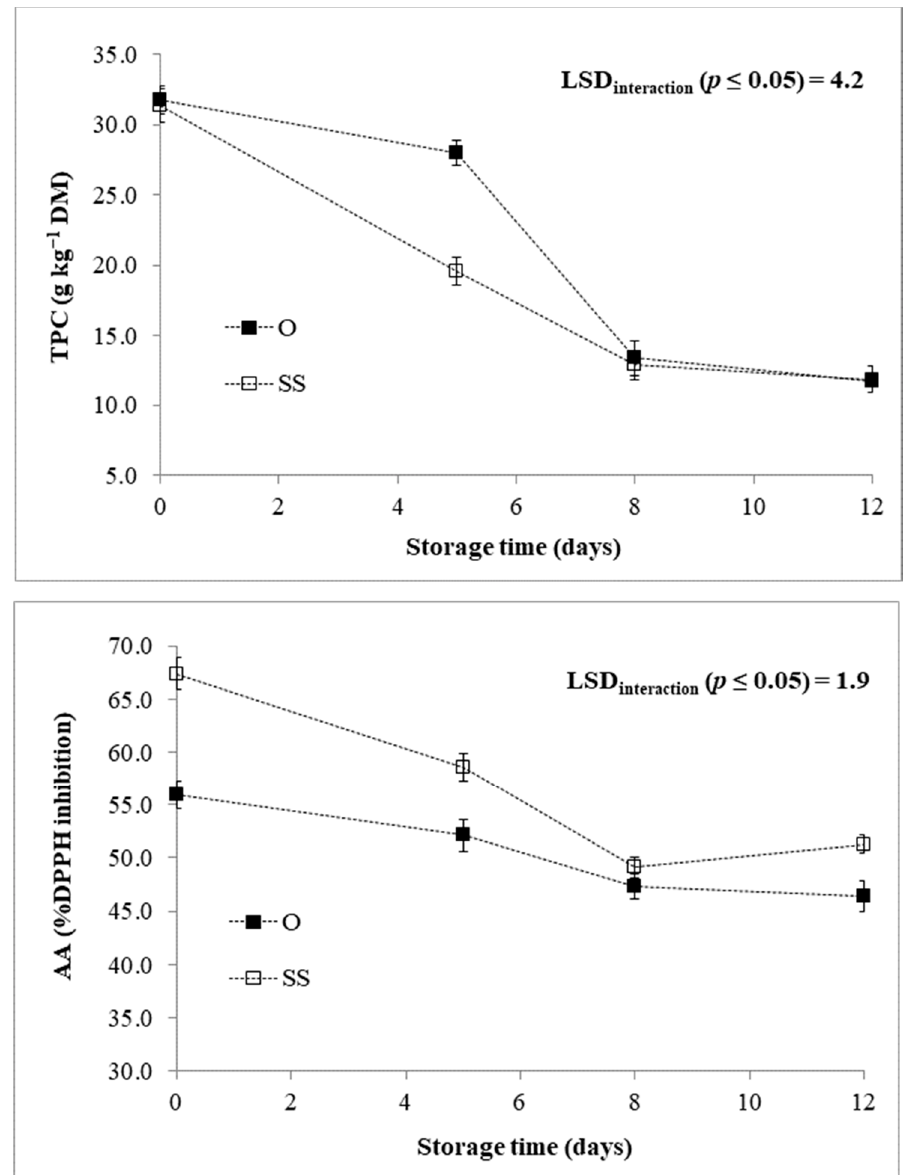
Figure 6. Chemical traits of RTC globe artichoke slices as affected by “genotype × storage time” interaction. TPC: Total polyphenol content; AA: Antioxidant activity; O: “Opera F1”; SS: “Spinoso sardo”. Data are presented as means ± standard deviation.